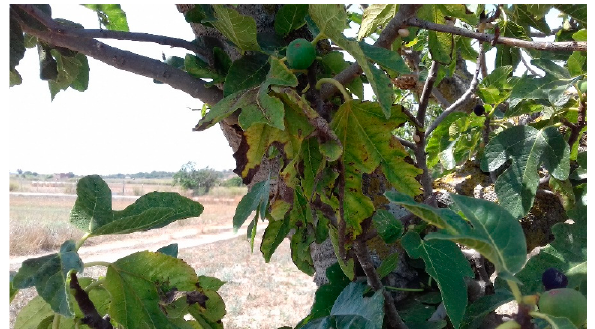
Figure 4. Leaf symptoms of fig tree ( Ficus carica ) infected by multiplex